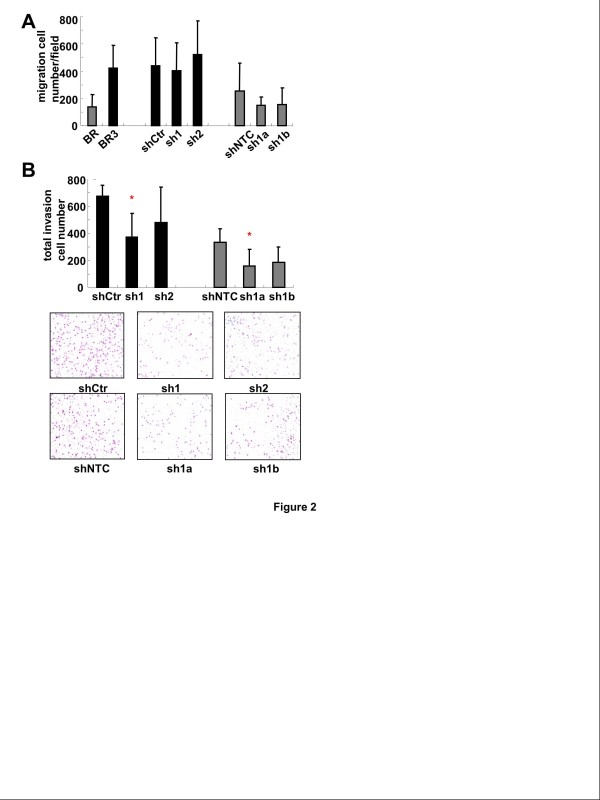
MMP-1 suppression inhibits invasion ability but not migration ability of 231-BR3 and 231-BR cell lines in vitro. A, 231-BR cells, 231-BR3 cells, control shRNA and MMP-1 shRNA expressing cells were tested for their ability to migrate to 5% FBS in the lower chamber of Transwell chambers. 2.5×104 cells were seeded in the migration chamber in serum-free medium. Migrated cells were fixed and counted after 24 h. MMP-1 knockdown in BR and BR3 cells did not affect cell migration ability. The data shown were combined from 5 independent experiments. B, control shRNA and MMP-1 shRNA expressing BR and BR3 cells were tested for ability to invade across a Matrigel-coated membrane in response to 5% FBS in the lower chamber. 2.5×104 cells were seeded in the invasion chamber in serum-free medium. Invaded cells were fixed and counted after 24 h. Asterisks indicate significant differences (P < 0.05) between control shRNA expressing cells and MMP-1 shRNA expressing cells. The data shown were combined from 5 independent experiments.